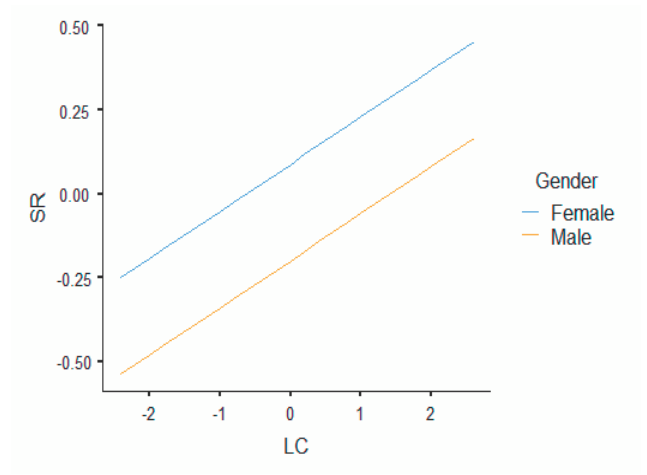
Figure 2. (cid:40)(cid:86)(cid:87)(cid:76)(cid:80)(cid:68)(cid:87)(cid:72)(cid:71)(cid:3)(cid:48)(cid:68)(cid:85)(cid:74)(cid:76)(cid:81)(cid:68)(cid:79)(cid:3)(cid:48)(cid:72)(cid:68)(cid:81)(cid:86)(cid:3)(cid:178)(cid:3)(cid:54)(cid:87)(cid:88)(cid:71)(cid:92)(cid:3)(cid:53)(cid:72)(cid:86)(cid:88)(cid:79)(cid:87)(cid:86)(cid:15)(cid:3)(cid:47)(cid:76)(cid:81)(cid:74)(cid:88)(cid:76)(cid:86)(cid:87)(cid:76)(cid:70)(cid:3)(cid:38)(cid:68)(cid:83)(cid:76)(cid:87)(cid:68)(cid:79)(cid:15)(cid:3)(cid:42)(cid:72)(cid:81)(cid:71)(cid:72)(cid:85)(cid:17) (cid:49)(cid:82)(cid:87)(cid:72)